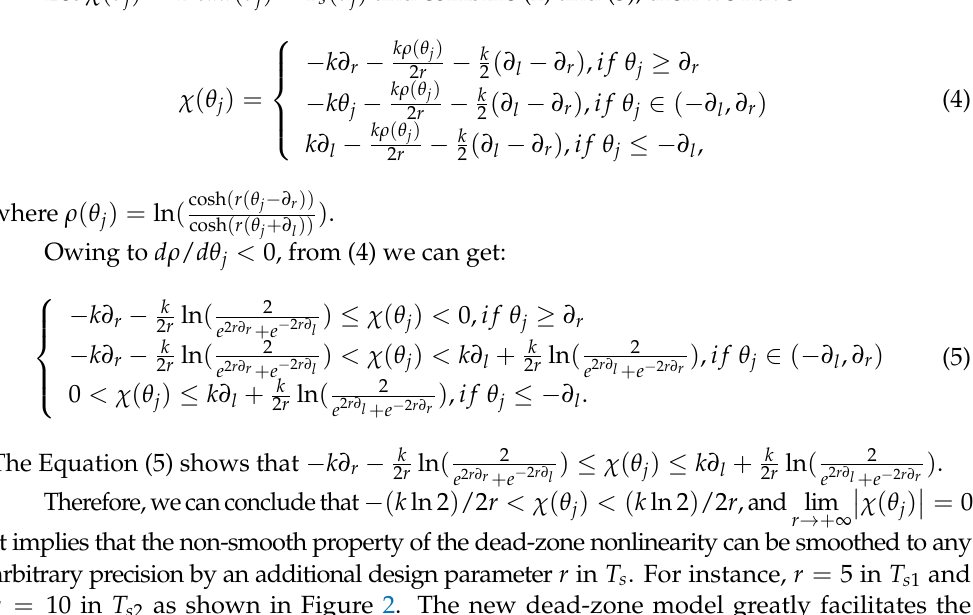
Figure 1. Structure diagram of the dual-motor synchronized driving servo system. ( ) Dead j